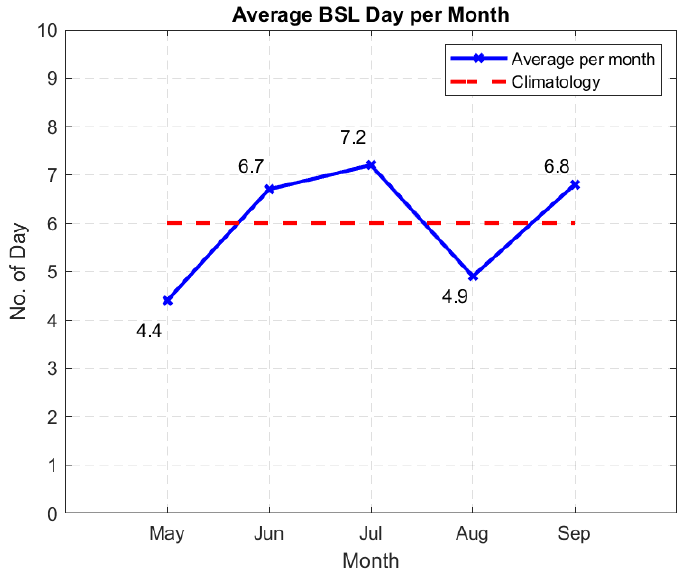
Figure 3. Average frequency (day) of BSL per month.